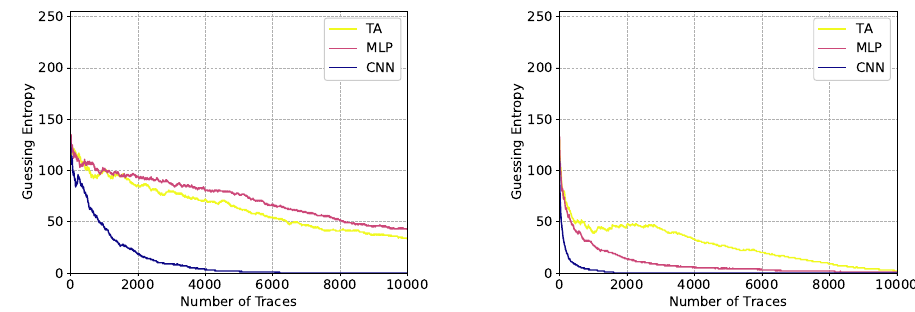
Figure 13: Guessing entropy: denoising Gaussian noise/desynchronization from less noisy traces.